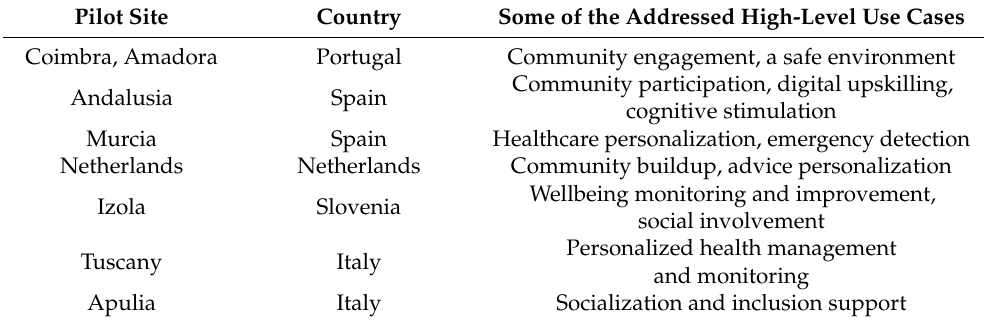
Table 1. Pilot sites and addressed high-level use